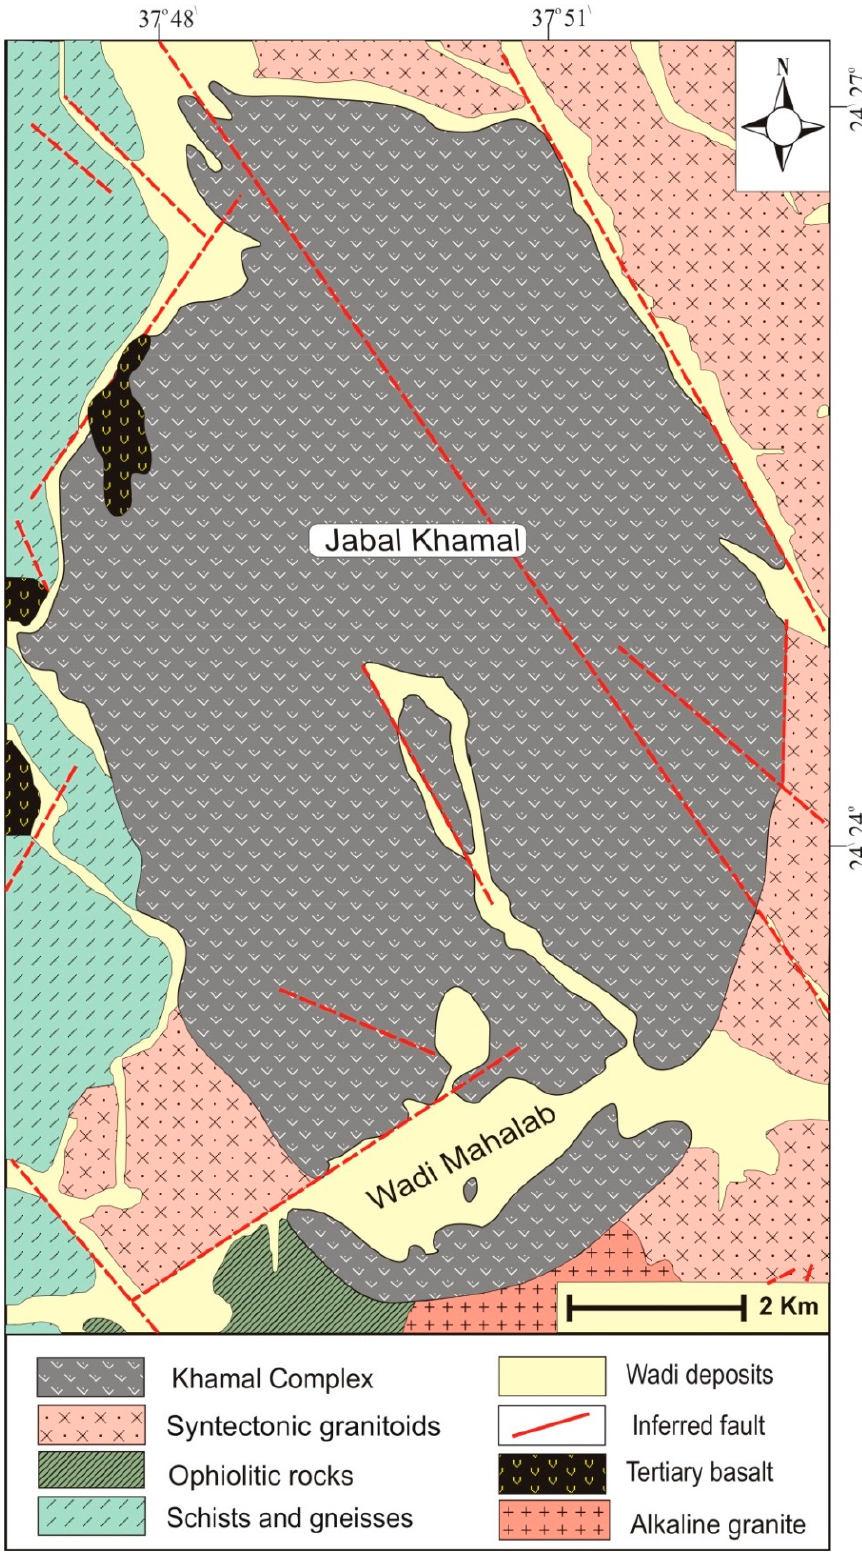
Figure 2. Geologic map of Wadi Khamal area (modified after [14]).